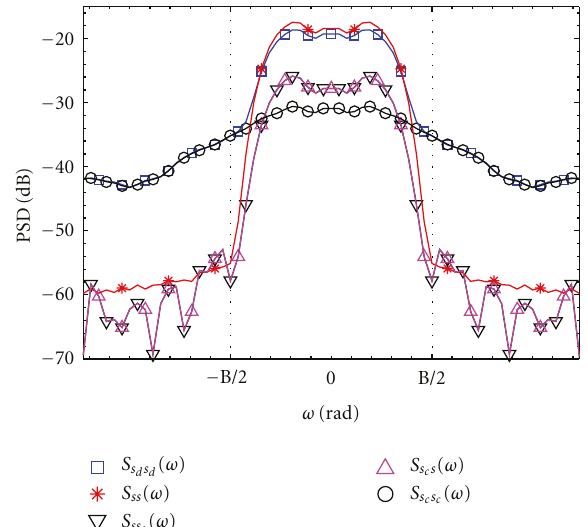
Figure 2: PSDs in (19) for an SRRC-filtered, 16-user baseband CDMA